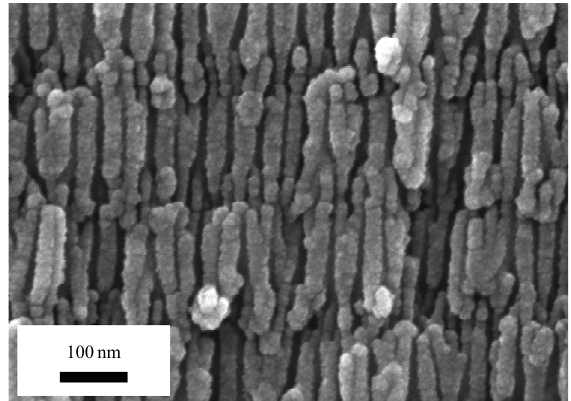
Fig. 1 Scanning electron microscopy image of the AAO PC cross